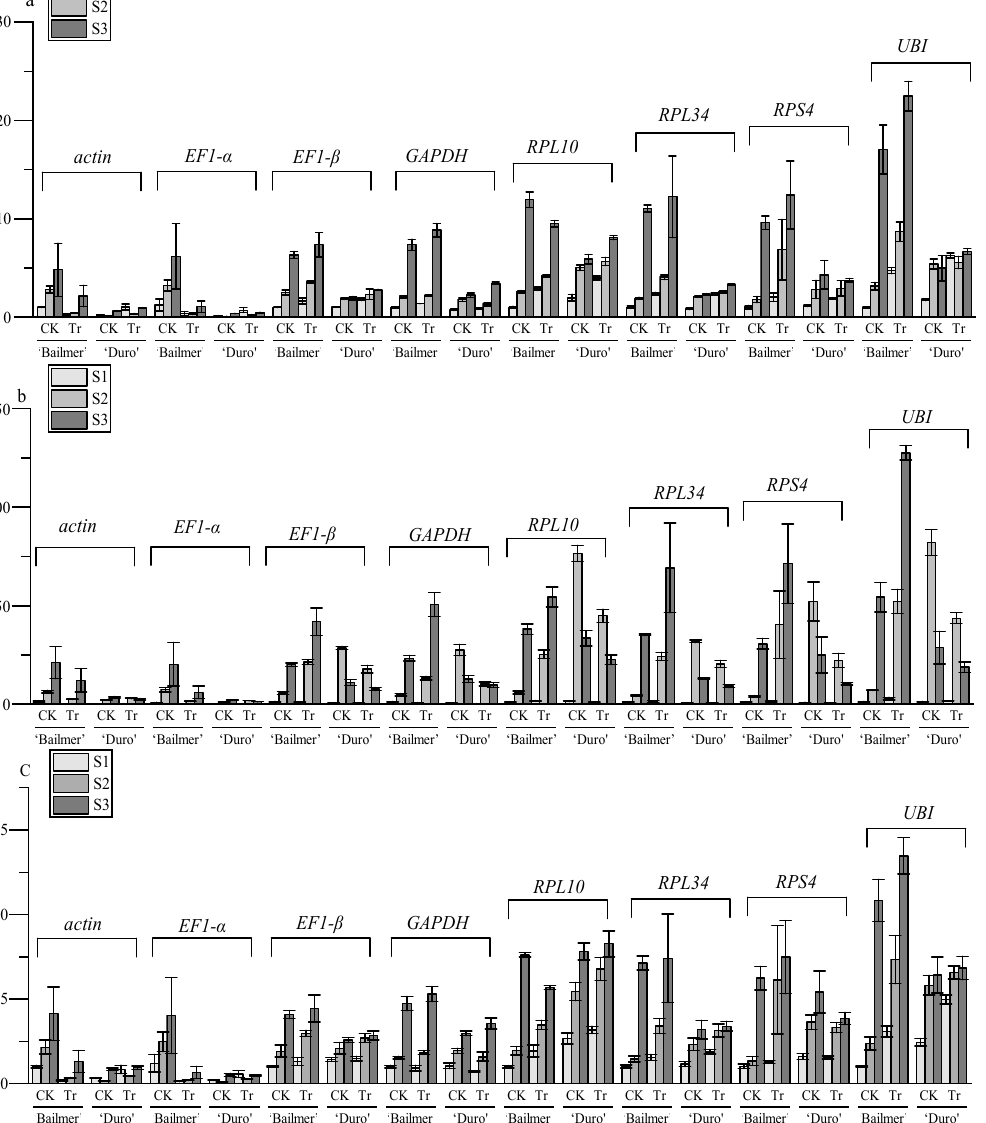
Figure 5. Genes expression verification. ( a ) Relative expression of CCR . ( b ) Relative expression of LODX . ( c ) Relative expression of NHX1 .